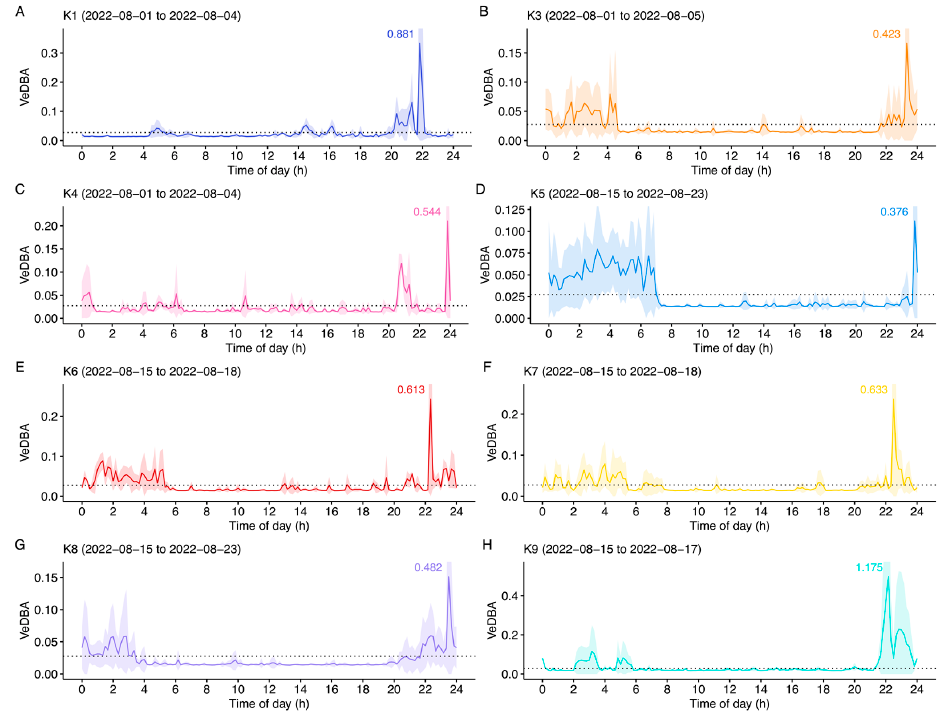
Figure 3. Average daily VeDBA for each individual (K1, K3 to K9 with the labels ( A – H ), respectively). Toad ID and tracking date range is shown on the top left in each panel. Graph color corresponds to colors in Figure 2. To improve visual representation, the upper ranges of SDs are cut-off. However, the maximum SD for each graph is provided next to the peaks. Note that the y-axis scales differ between individuals. The solid-colored line represents the mean VeDBA and the shaded area represents the standard deviation (SD). The horizontal dotted lines in each plot represent the overall mean VeDBA, calculated across all eight toads in the study, which was 0.027. K1 and K3 to K6 were males. K7 to K9 females.